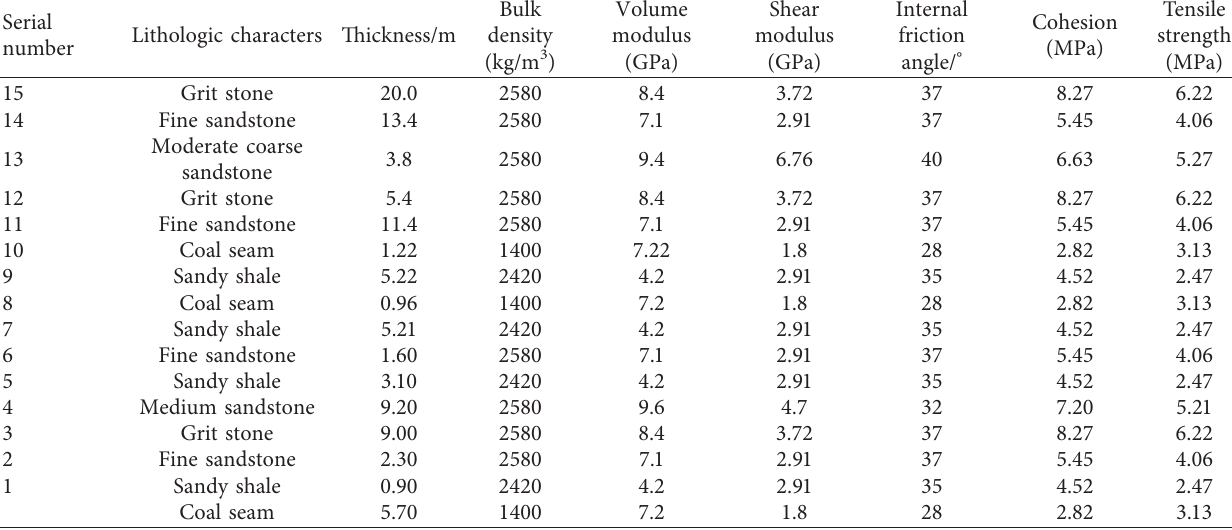
Table 3: The physical and mechanical property parameters of the numerical simulation experimental model coal.